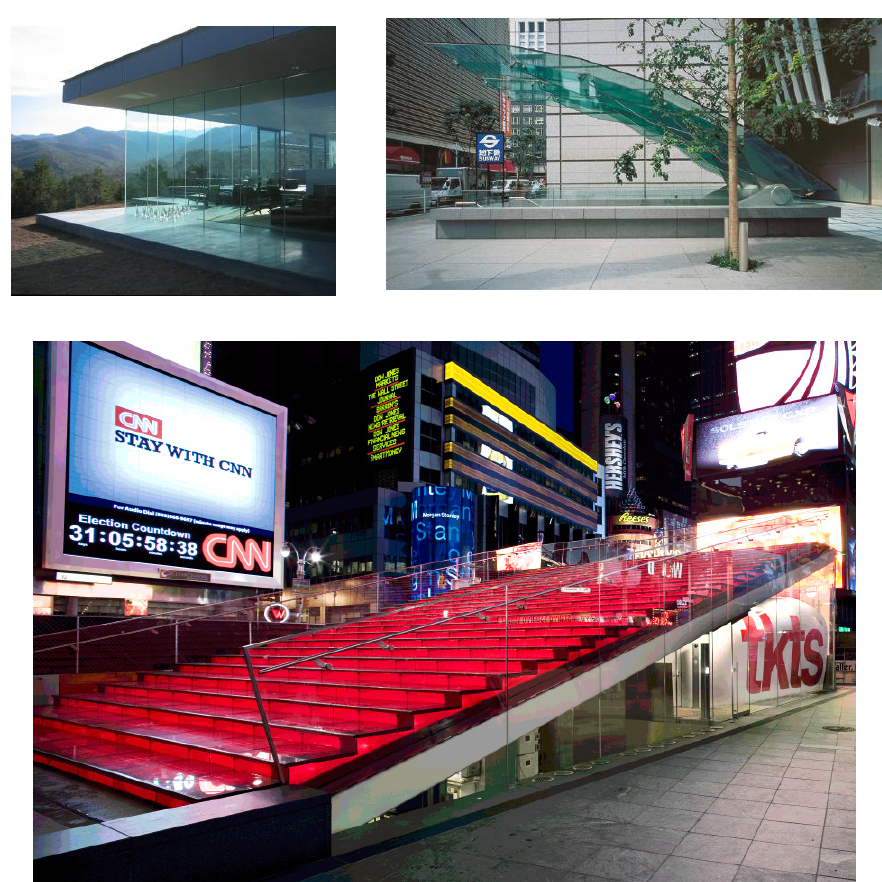
Figure 1: Top left – Klein house with load bearing glass walls. Top Right – Yurakucho Canopy with overlap splced beams. Bottom: TKTS